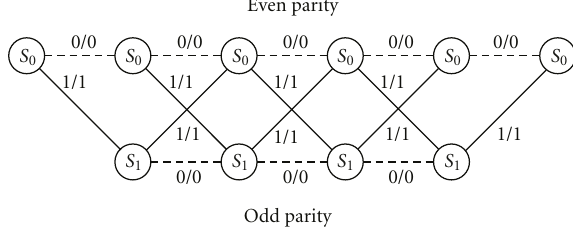
Figure 8: Two-state trellis representation of a parity-check con- straint with d c =